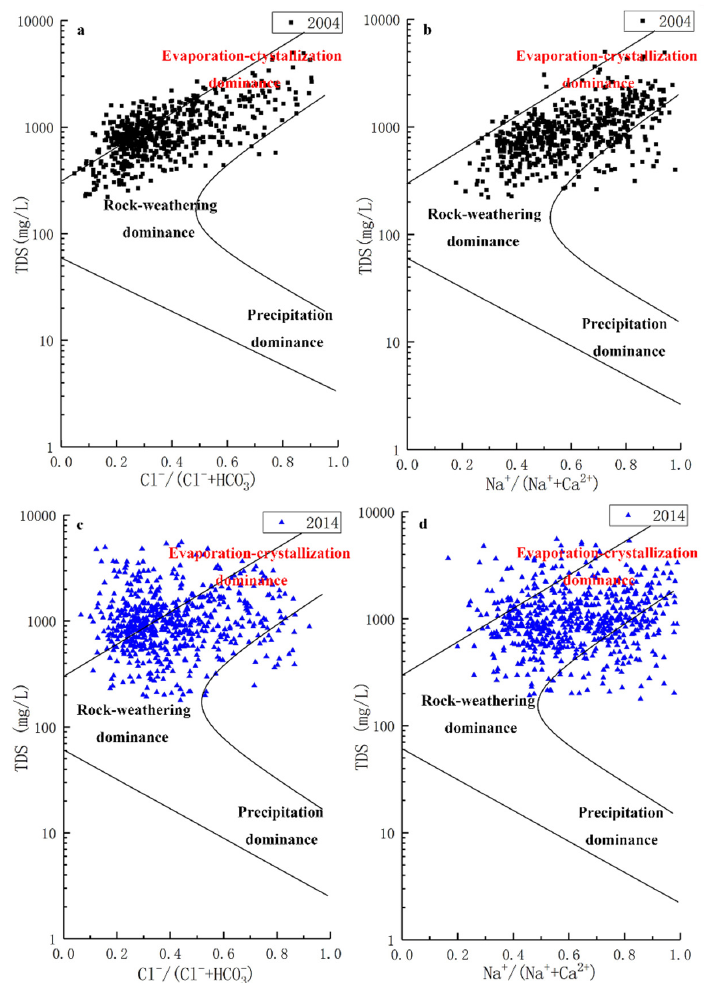
Figure 3. Gibbs plots: diagrammatic representation of processes controlling the chemistry of the study area groundwater, indicating rock-weathering interaction and evaporation-crystallization as the major process regulating the chemistry of the groundwater in the study area. Variation of Cl (cid:2879) /( Cl (cid:2879) + HCO (cid:2871)(cid:2879) ) as a function of the total dissolved solids (TDS) of the study area groundwater in ( a ) 2004 and ( c ) 2014; Variation of Na (cid:2878) /( Na (cid:2878) + Ca (cid:2870)(cid:2878) ) as a function of the TDS of the study area groundwater in ( b ) 2004 and ( d ) 2014.